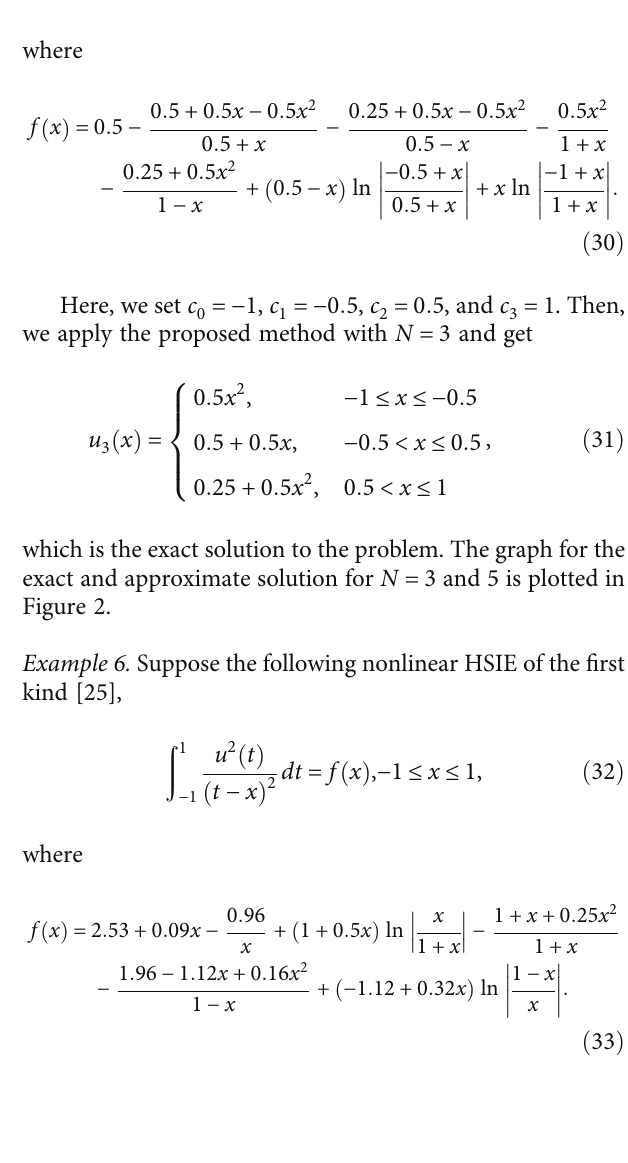
Figure 1: The graph of exact solution u ð x Þ and approximate solutions u 2 ð x Þ , u 4 ð x Þ , u 6 ð x Þ for Example